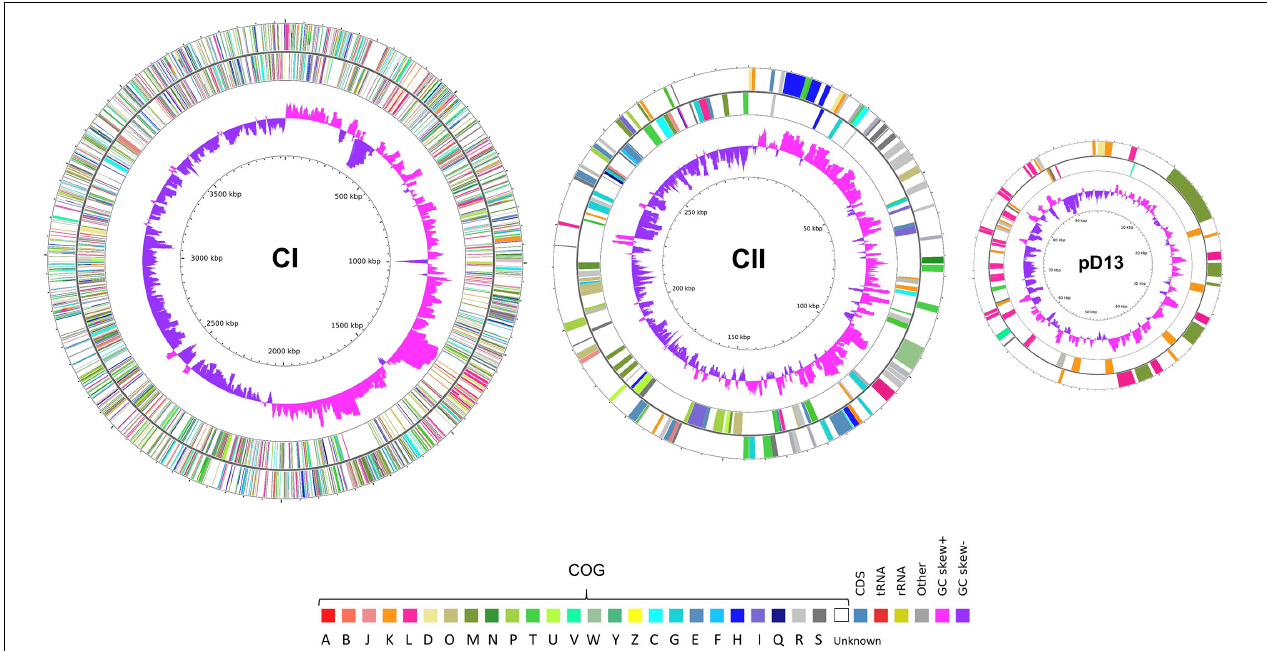
FIGURE 2 | Circular maps of three replicons of L. weilii serogroup Mini strain CUD13. The outermost and second outermost rings represent genes on the sense and antisense strands colored according to COG categories annotation. The COG categories are denoted as follows: A (RNA processing and modification), B (chromatin structure and dynamics), J (translation, ribosomal structure and biogenesis), K (transcription), L (replication, recombination, and repair), D (cell cycle control, cell division, and chromosome partitioning), O (post-translational modification, protein turnover, and chaperones), M (cell wall/membrane/envelope biogenesis), N (cell motility), P (inorganic ion transport and metabolism), T (signal transduction mechanisms), U (intracellular trafficking, secretion, and vesicular transport), V (defense mechanisms), W (extracellular structures), Y (nuclear structure), Z (cytoskeleton), C (energy production and conversion), G (carbohydrate transport and metabolism), E (amino acid transport and metabolism), F (nucleotide transport and metabolism), H (coenzyme transport and metabolism), I (lipid transport and metabolism), Q (secondary metabolites biosynthesis, transport, and catabolism), R (general function prediction only), and S (function unknown). The second inner ring indicates the GC skew; positive skew is shown in pink-purple, and negative skew is shown in purple. The genome map was created and visualized using CGView (Stothard and Wishart,